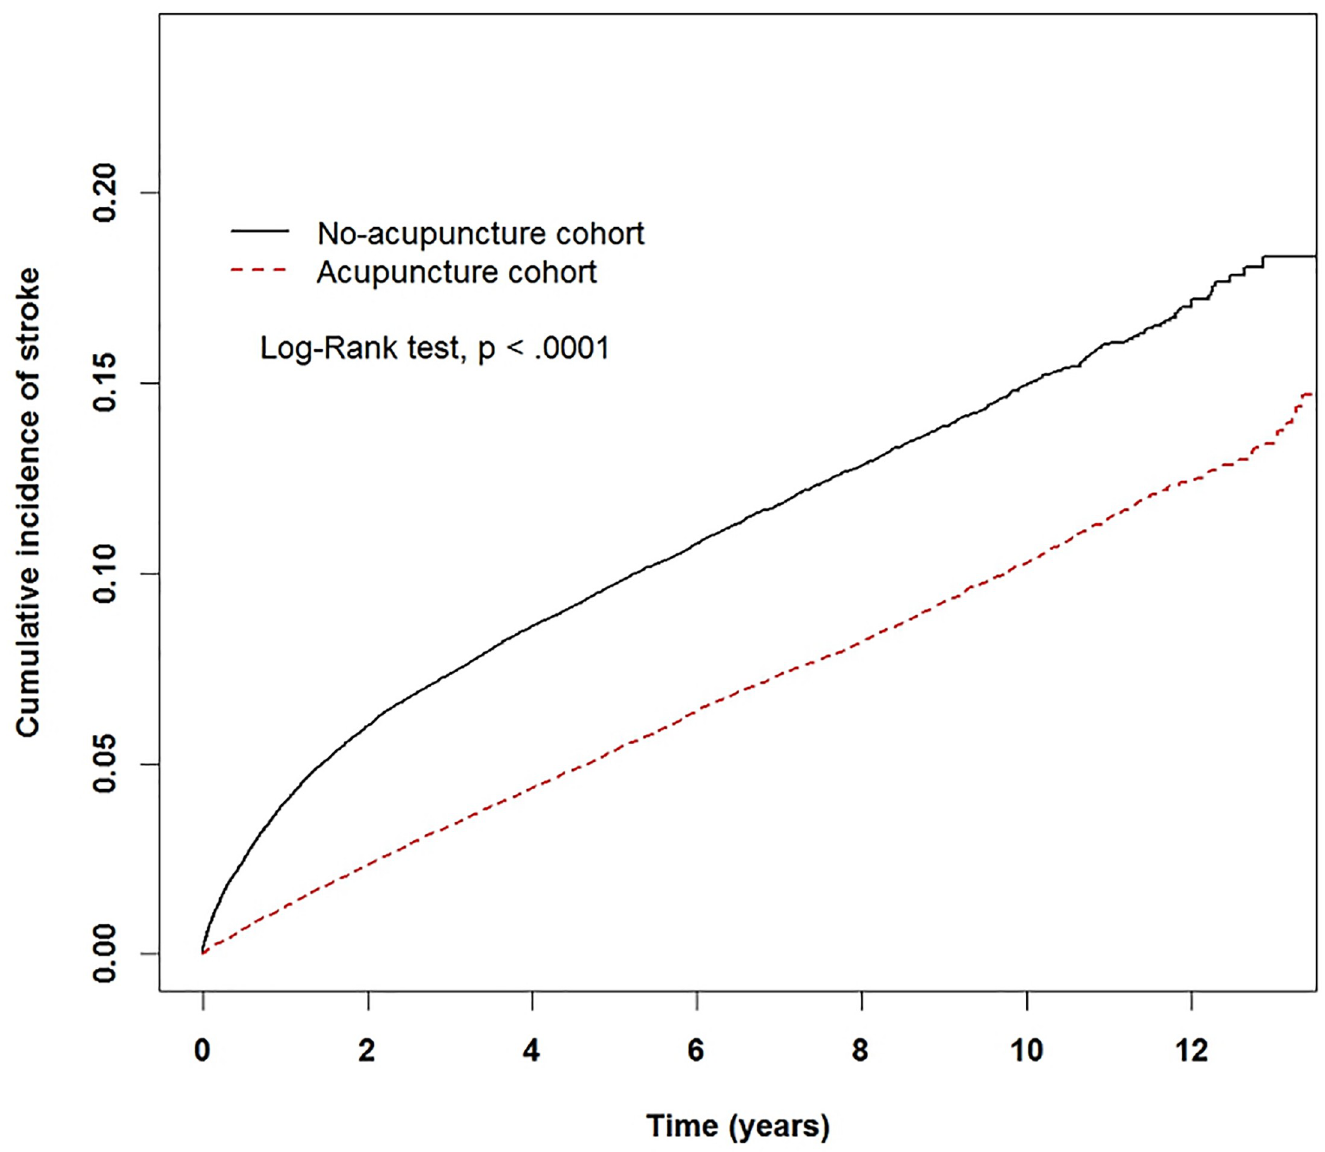
Fig 2. The estimated cumulative incidence of stroke for the acupuncture and non-acupuncture cohorts with fibromyalgia. Result of Kaplan-Meier analysis showed that the incidence of stroke in the acupuncture cohort was significantly lower than that in the non-acupuncture cohort.